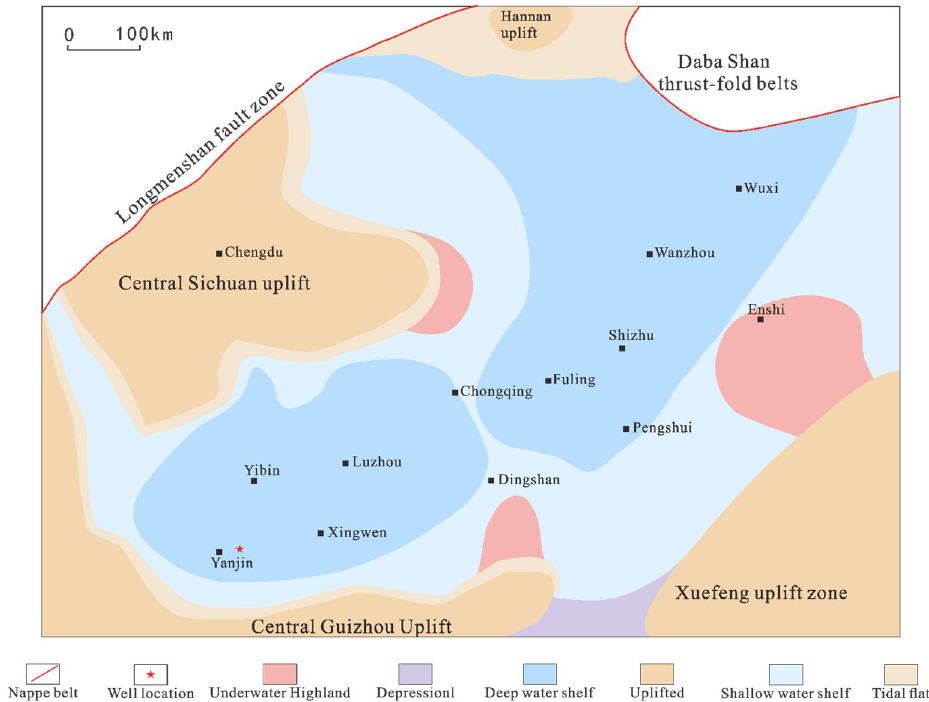
Figure 1. Sedimentary facies and shale distribution in the study area and its periphery. Table 1. Information on shale gas well rock